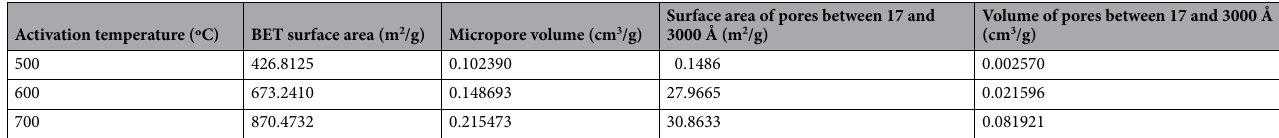
Table 3. Surface area and porosity properties of steam activated carbon determined by gas adsorption (BET) analyzer.